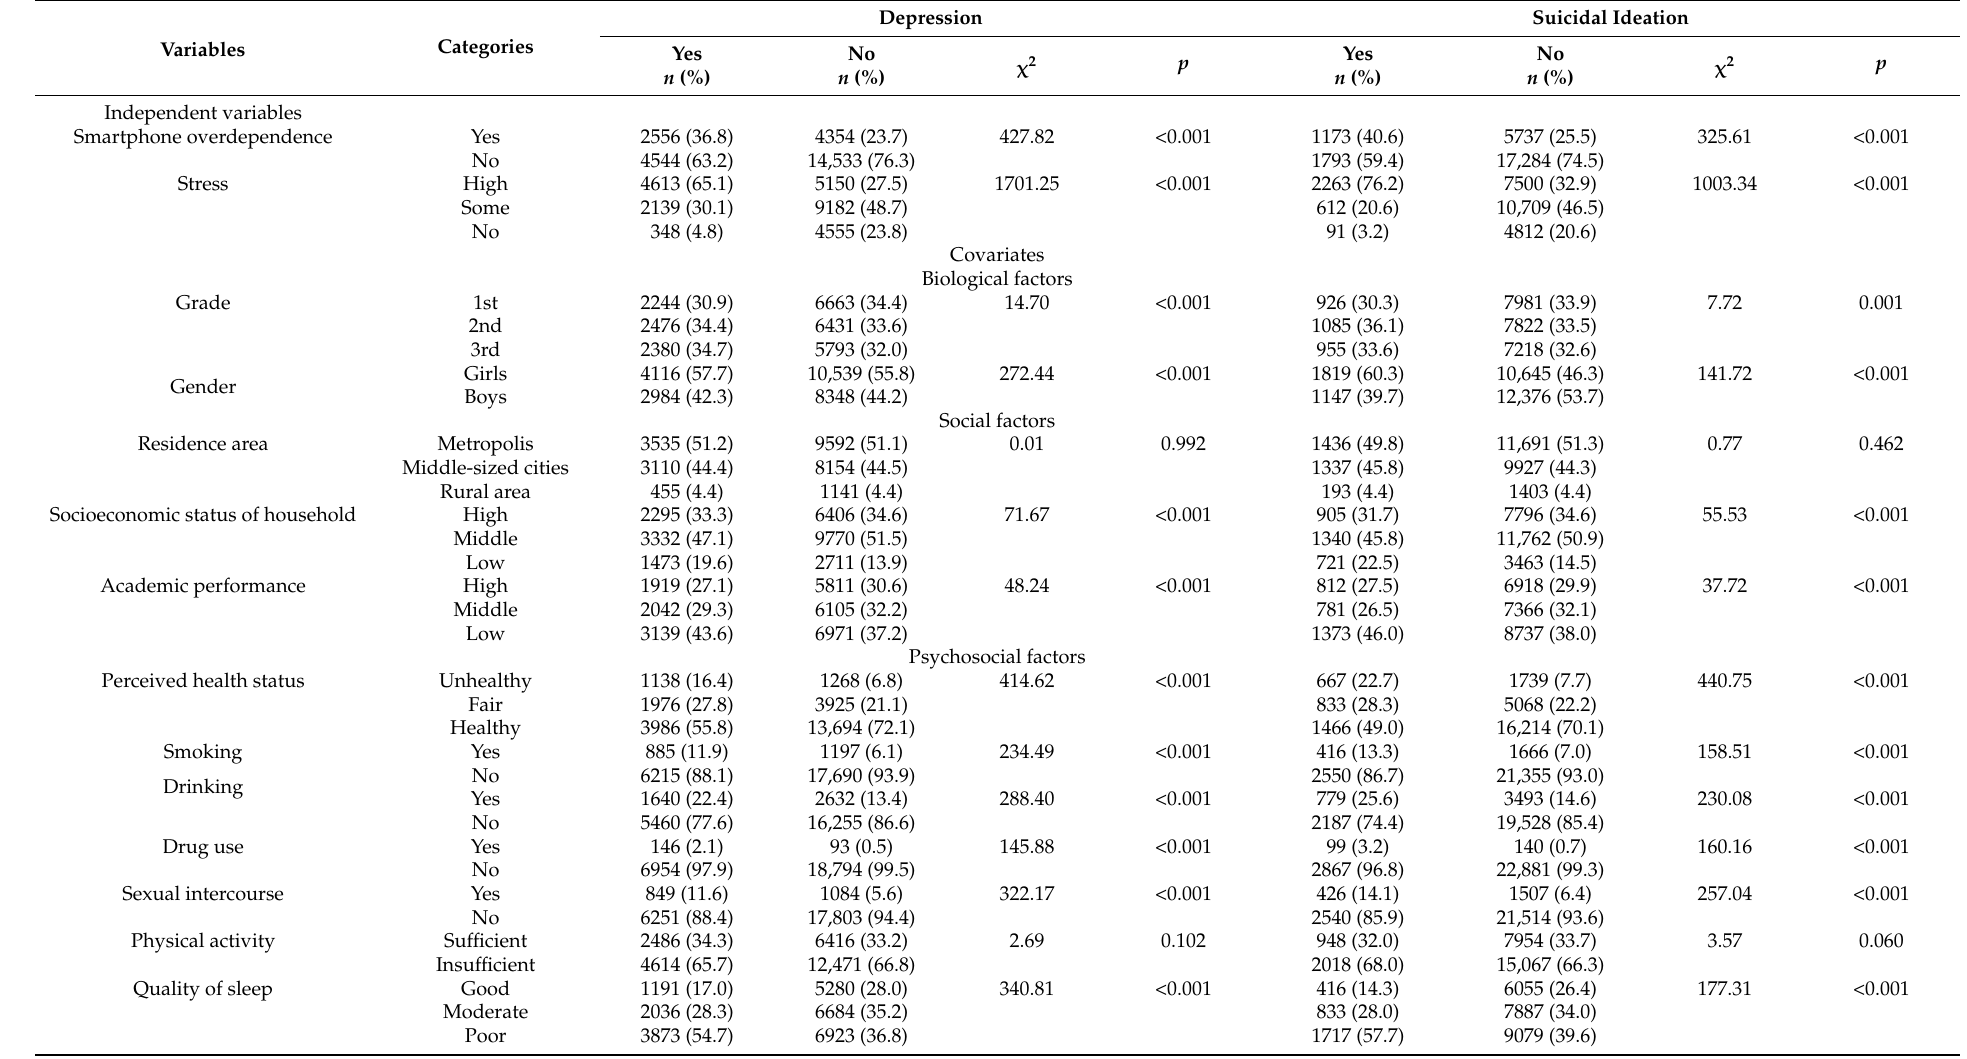
Table 2. Differences in depression, suicidal ideation, suicidal plans, and suicidal attempts based on smartphone overdependence, stress, and